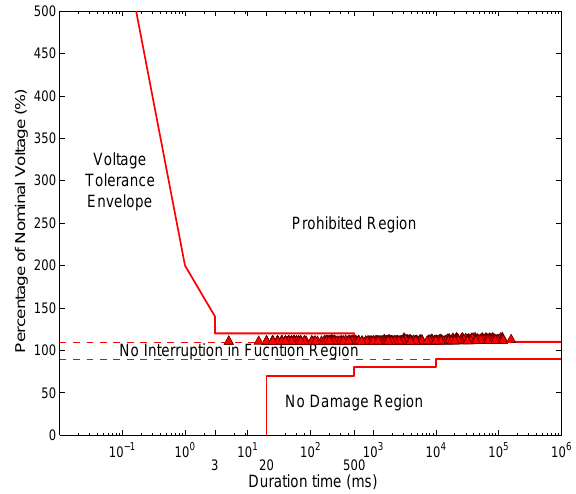
Figure 8. ITIC curve for dips and swells voltage values after the grid strengthening during one day. Swells are marked with red upwards ‐ pointing triangles and dips are marked with green downwards ‐ pointing triangles.